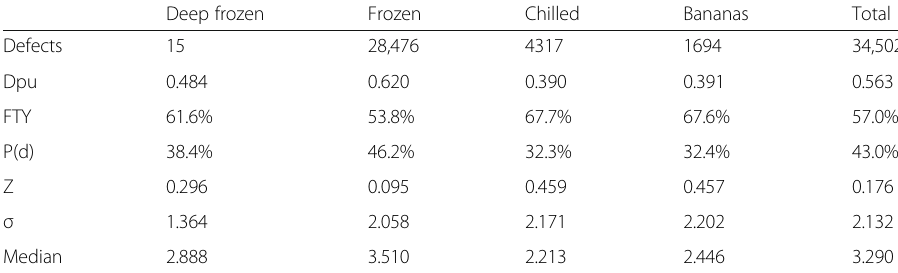
Table 4 Transshipment time performance Deep frozen